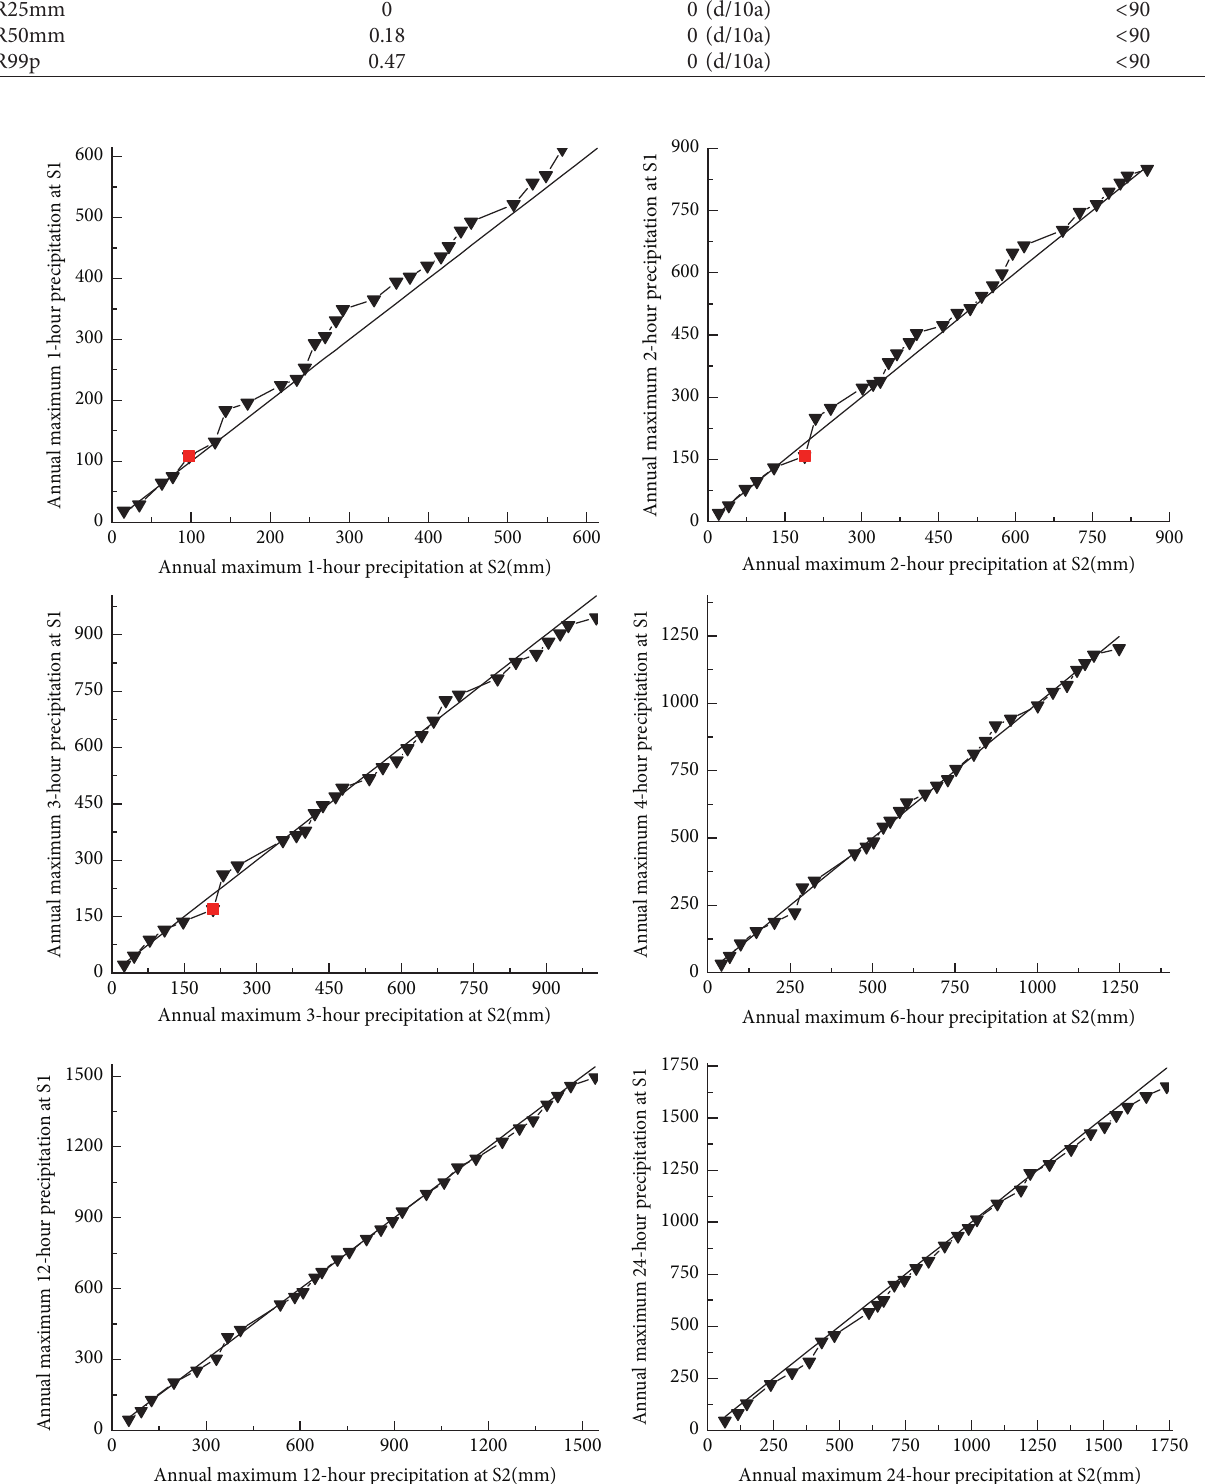
Figure 12: Double cumulative curves of the precipitation at urban and rural stations of the study area from 1982 to